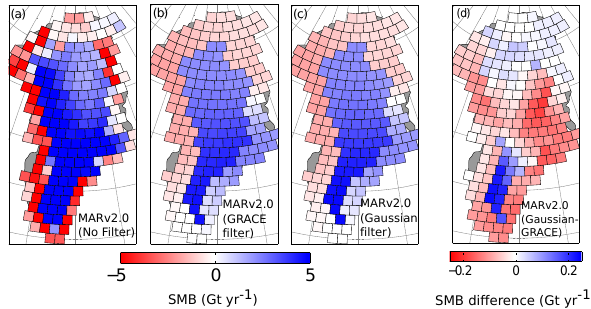
Figure 2. Average MAR v2.0 SMB (Gtyr − 1 ) for the period Jan- uary 2003–December 2010: (a) averaged onto GRACE-LM mas- cons with no filtering, (b) filtered using the resolution operator from GRACE-LM processing, (c) filtered using a Gaussian approxima- tion to GRACE-LM filtering in space and time. (d) The difference between (a) and (b) . Note the difference in color scale for (d)